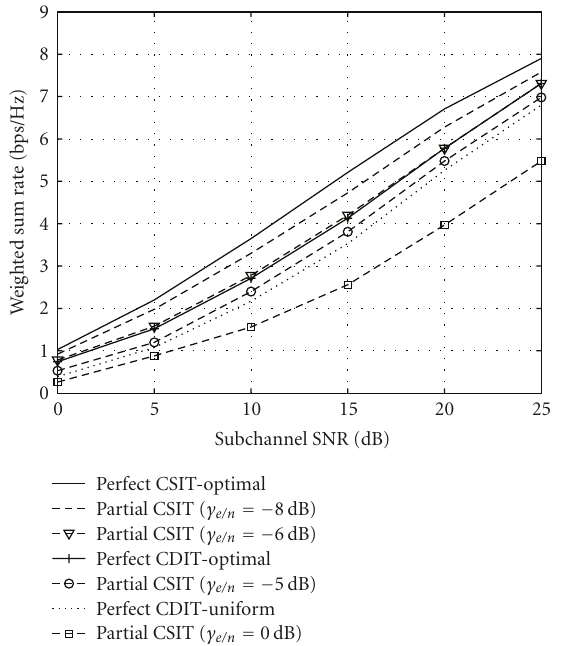
Figure 1: Maximized weighted-sum rate versus mean SNR for dif- ferent resource allocation schemes and fairness parameter α f = 0.